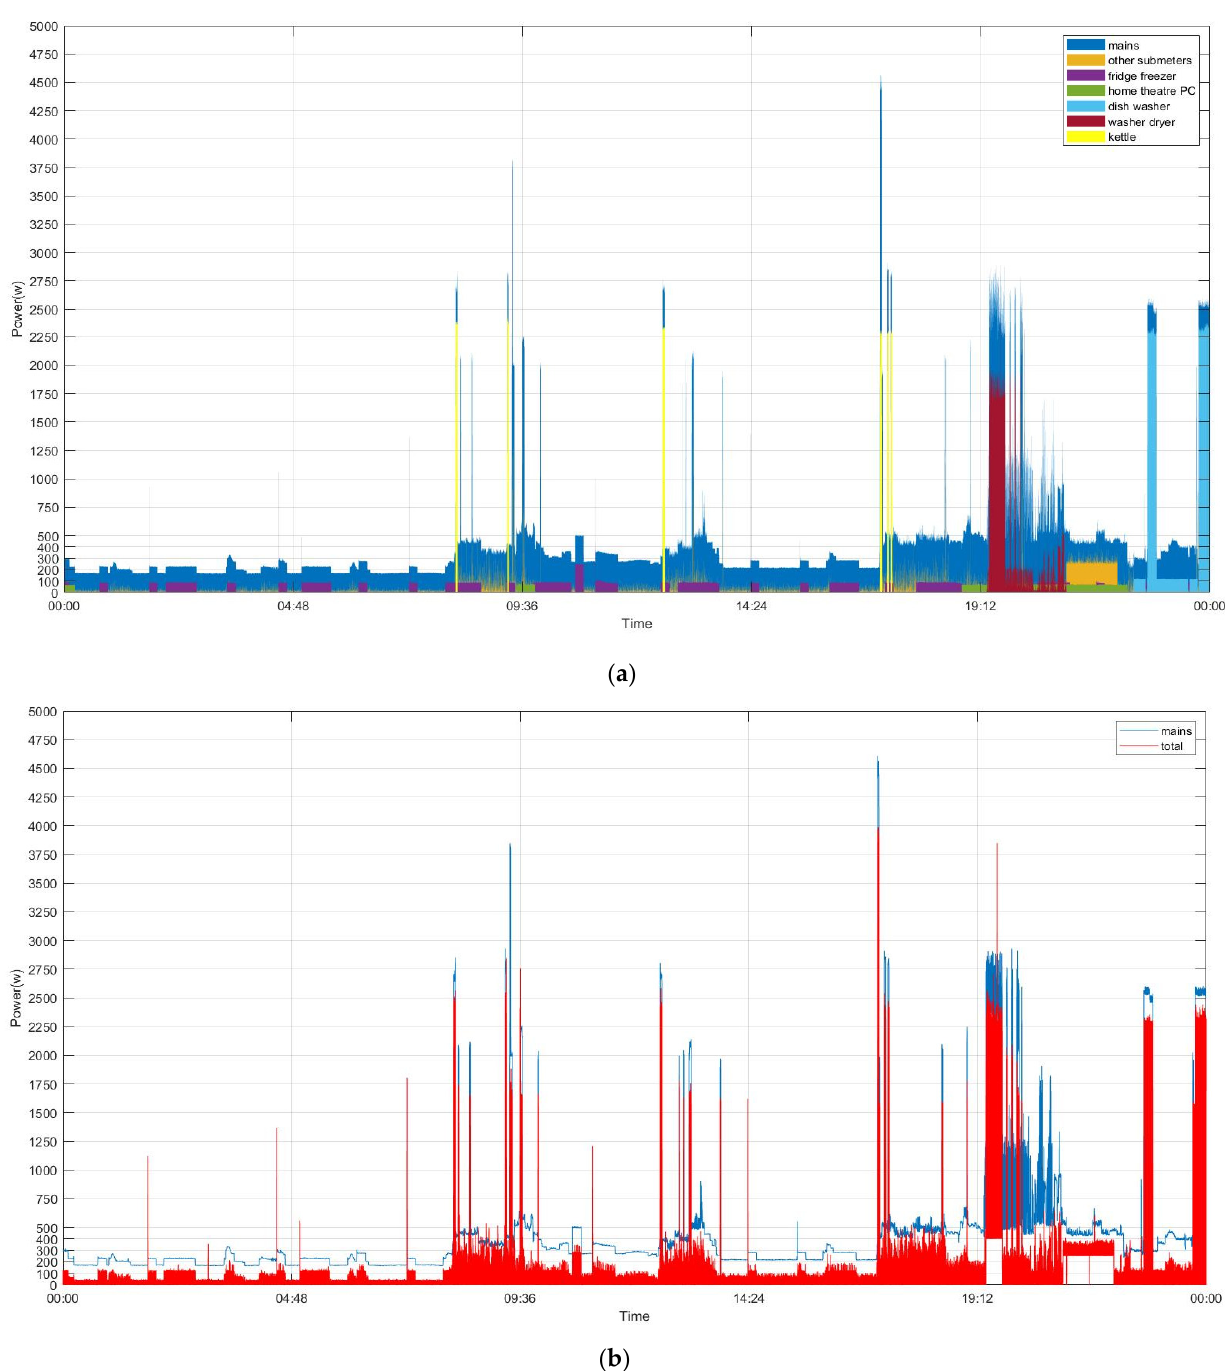
Figure 5. The considered historical power demand on Sunday 7 December 2014 in House 1, which was monitored and recorded in the UK-DALE dataset [27], conditioned in [7] and examined in this research: ( a ) the total (composite) power demand, to be decomposed into the individual power demand where base, permanent and phantom power demand existed, in the mains; ( b ) a base load, permanent load, and phantom load existed in the mains. This figure is from [7].